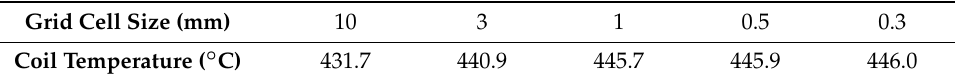
Table 2. Sensitivity analysis of grid size.